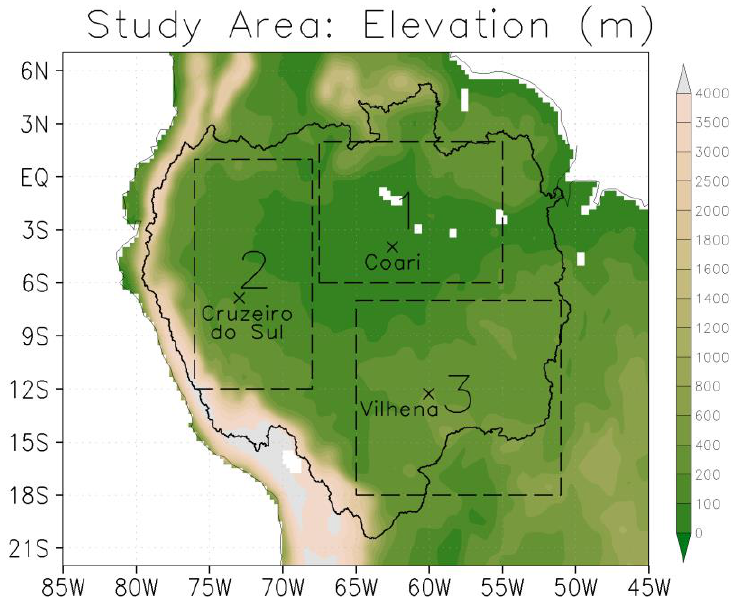
Figure 1. Study area elevation (m) from the Satellite-Enhanced Regional Downscaling for Applied Studies (henceforth SRDAS). Delimited with boxes (dashed lines) are regions north (1), west (2) and southeast (3) in the Amazon basin. Station sites are marked with “X”, namely: Coari (AM), Cruzeiro do Sul (AC), and Vilhena (RO).